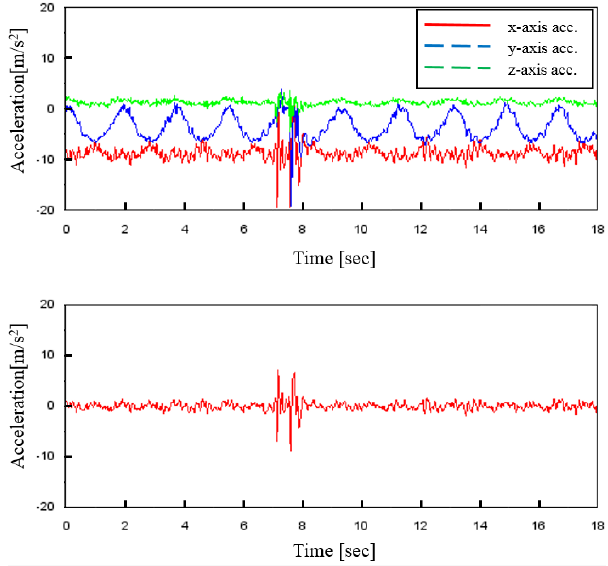
Figure 6: Observed signals from smartphone in the pockcet of trousers(upper) and extracted signal by applying